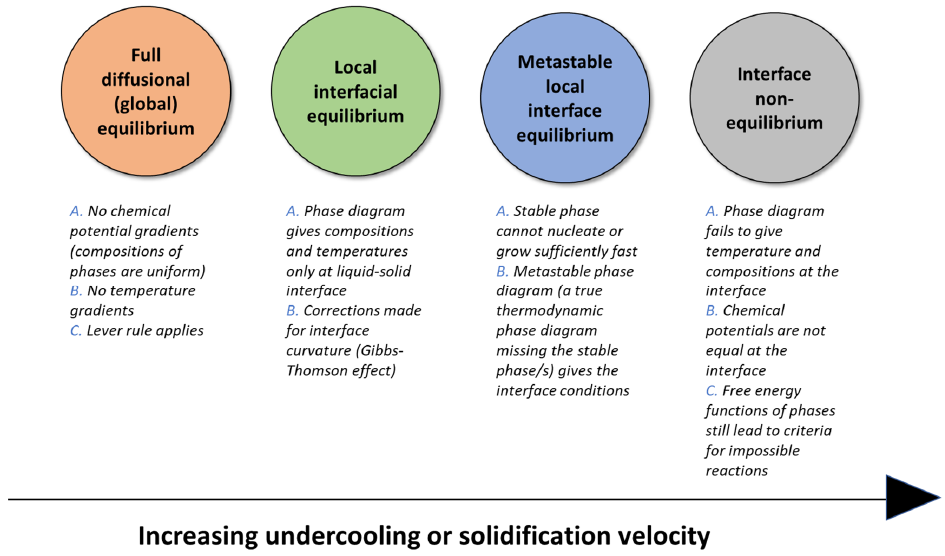
Figure 8. Hierarchy of equilibrium. (Information for this figure was drawn from [43]). AM processes operate under the ‘interface nonequilibrium’ conditions where the equilibrium phase diagram fails, and chemical potentials on either side of the liquid–solid interface are no longer equal. In these instances, when the solidification velocity exceeds a certain critical velocity for the multi-component alloy system, the solute is trapped in the rapidly freezing primary solid phase. This is because the solute atoms are unable to diffuse ahead of the fast-moving liquid–solid interface, and the concentration exceeds the solubility limit. Several models have been advanced to describe this experimentally observed phenomenon [31]. Recently, purely quantitative phase field models have been developed from fundamental considerations for predicting solute trapping at velocities relevant to AM, e.g., [31] for the Si-9at.%As system. Similar numerical models are required for other alloys used in AM to simulate microstructure formation accurately. In many cases, the experimental data are not yet available—partially due to the considerable effort involved in collecting all the relevant information, e.g., the extensive range of AM process parameters that generate alternative phase transformation routes. Therefore, the numerical models can help limit the number of physical experiments needed to determine the solute trapping behaviour. For predictions involving multi-component alloy systems, phase field models use thermodynamic data obtained from the phenomenological CALPHAD (calculation of phase diagrams) method. The information is used to evaluate alloy phase constitution, the solidification path, basic alloy properties such as partition coefficients (for calculating solute trapping), slopes of liquidus, and solidus phase boundaries. Since the CALPHAD data are typically developed for equilibrium scenarios, they are modified for simulating nonequilibrium processes by using empirically derived models (e.g., Scheil–Gulliver). However, the approaches used so far have limitations [44] and can be improved to support more realistic predictions of microstructures in an AM process simulated at the continuum (or engineering) scale. Some recent efforts (e.g., [44,45]) have improved the quality of microstructure predictions for AM builds. For instance, in an article that is part of the current Special Issue, Sargent et al. [44] have combined continuum scale thermal simulations of the L-PBF process of stainless steel SS316L with a phenomenological microstructure model. Solute redistribution (or microsegregation) was calculated using DICTRA [46], a module that works with the commercial CALPHAD software Thermo- Calc [47]. (DICTRA and Thermo-Calc are registered trademarks of Thermo-Calc Software